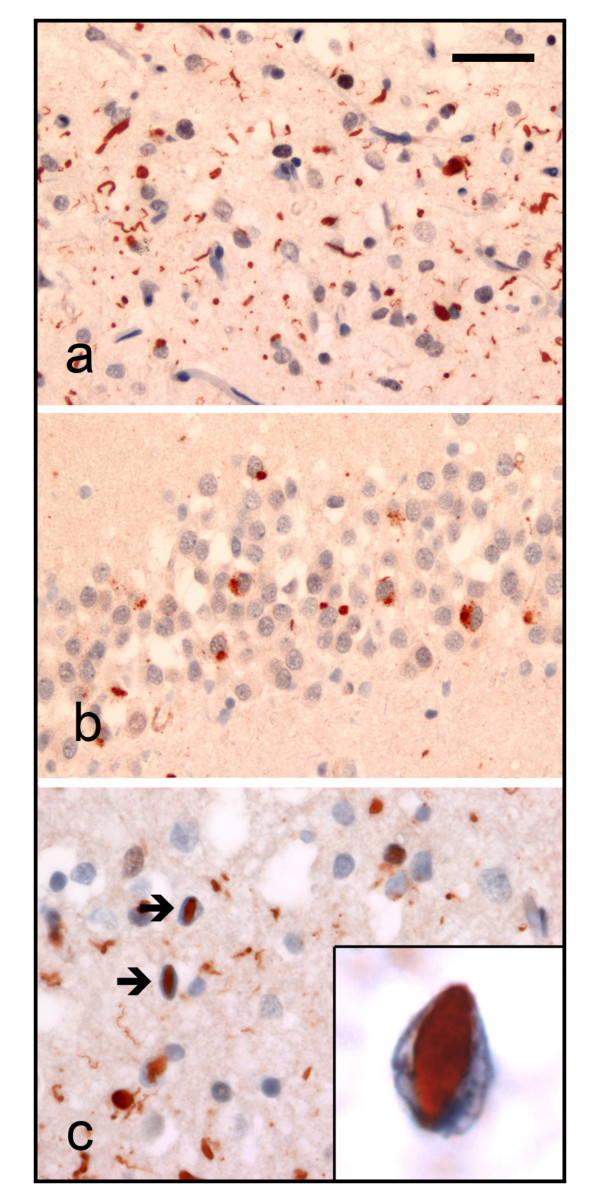
Neuropathologic analysis of brain tissue from FTLD-Upatients. Ubiquitin immunohistochemistry in cases of familial FTLD-U demonstrates staining of (a) neurites and neuronal cytoplasmic inclusions in the superficial cerebral neocortex, (b) neuronal cytoplasmic inclusions in hippocampal dentate granule cells, and (c) neuronal intranuclear inclusions in the cerebral neocortex (arrows). Scale bar; (a) and (b) 40 μm, (c) 25 μm, insert 6 μm.